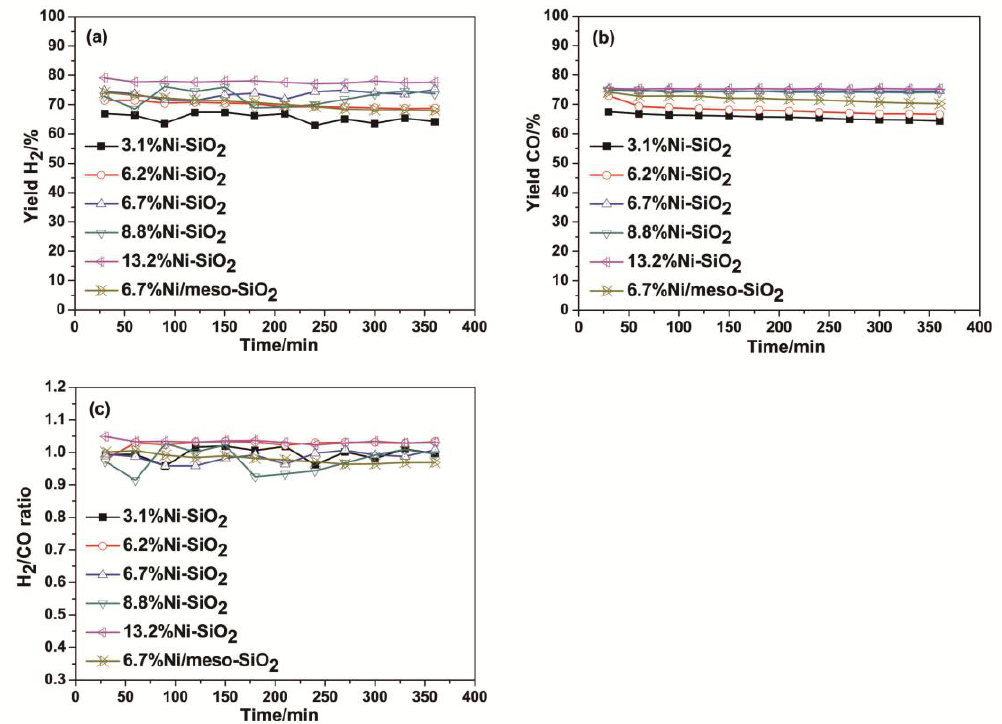
Figure 7. Effect of nickel content on the yields of the ( a ) H the dry reforming of methane with carbon dioxide at 650 °C and a gas hourly space velocity (GHSV) of 24,000 mL∙h −1 ∙g −1 .